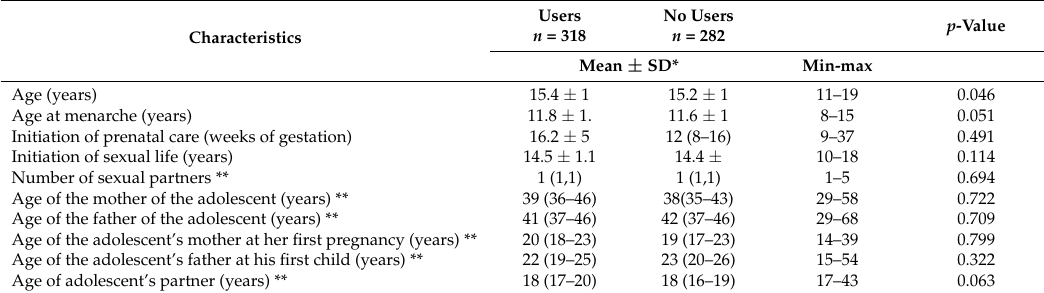
Table 1. Sociodemographic characteristics of the adolescents and their parents, according to users and non-users of birth control methods before pregnancy.